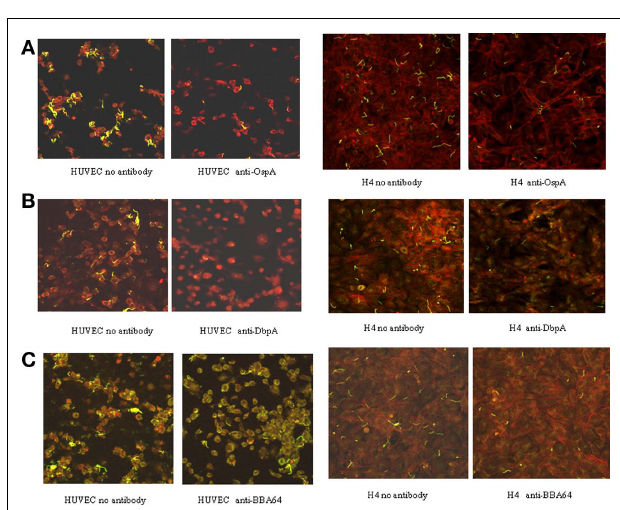
FIGURE 2 | Confocal microscopy of fluorescent-stained B. burgdorferi bound to HUVEC and H4 cells. Panels on the left show Borrelia attachment with no antibody treatment (i.e., the anti- Bartonella control); panels on the right show Borrelia attachment following incubation with anti-surface protein mAb. (A) anti-OspA; (B) anti-DbpA; (C)